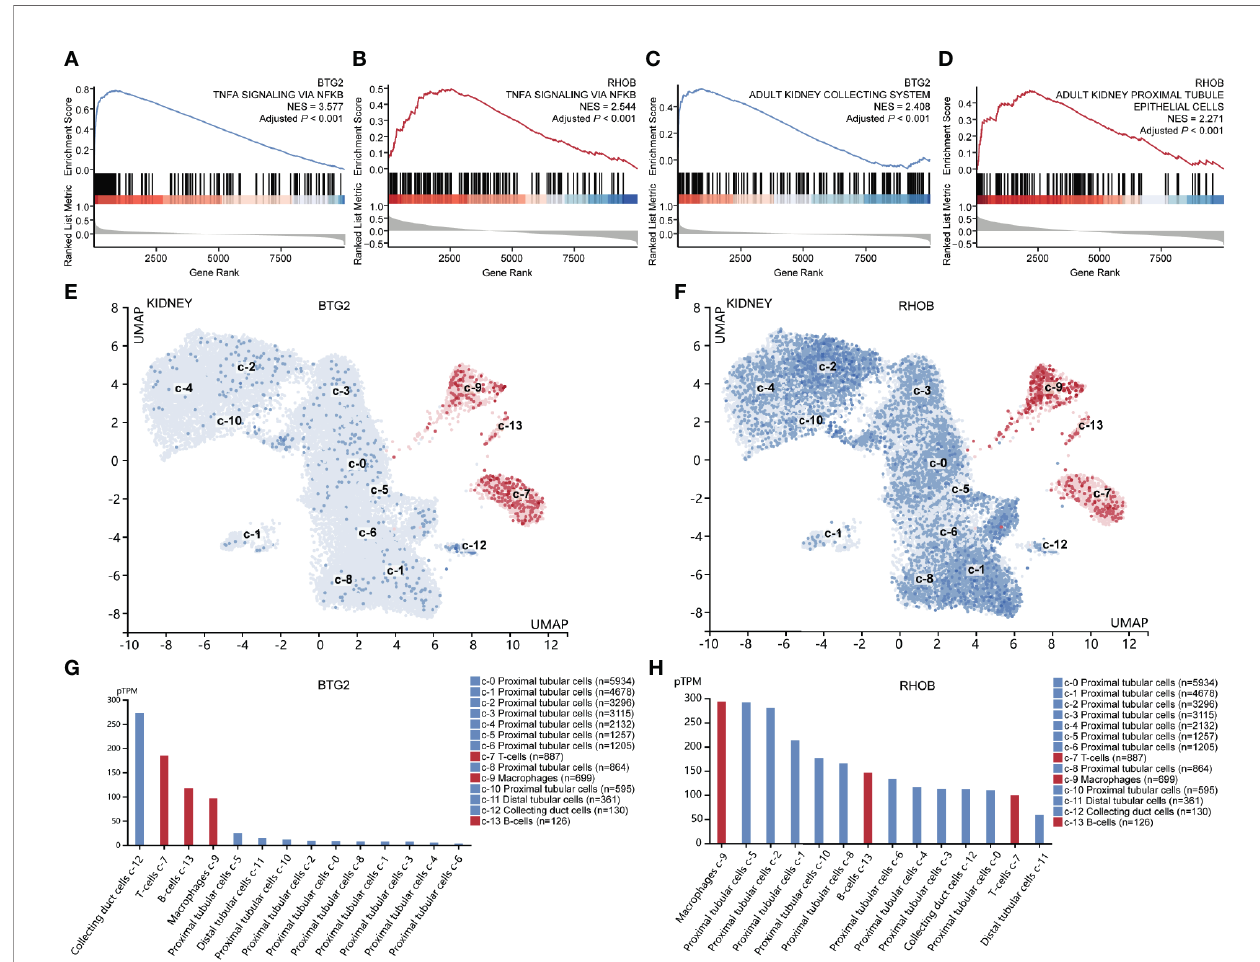
FIGURE 6 | Gene set enrichment and single-cell analyses of Btg2 and Rhob . Enriched hallmark gene signatures (A, B) and cell type signatures (C, D) of Btg2 and Rhob . UMAP clustering of Btg2 and Rhob in the kidney (E, F) . The red color represents immune cell types, and the blue color represents other renal cell types. Cell types are sorted from high to low according to expression levels in bar graphs (G, H) . UMAP, uniform manifold approximation and